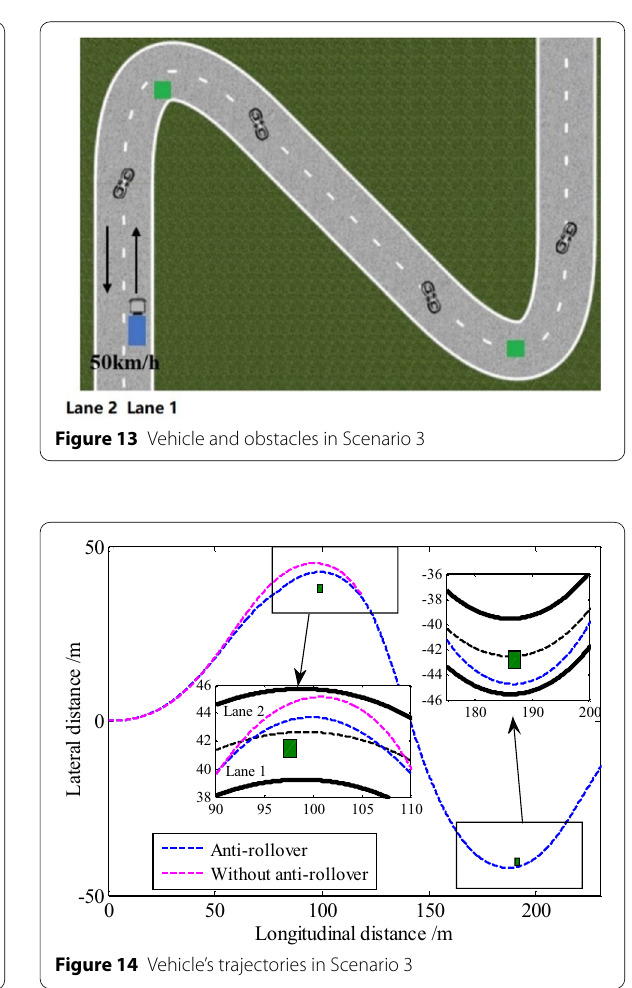
strategy still puts up a good performance in longitudi- nal stability in Scenario 2. Scenario 3: Extreme turning condition. As shown in Figure 13, an extreme urgent scenario is designed to vali- date the performance of the motion planning with active anti rollover ability. The intelligent heavy truck runs on a two-way lane at a speed of 50 km/h. There are two large detours in this section lane. A fixed obstacle of 1 m in length and width suddenly appears on Lane 1 when the ego vehicle is 15 m away from the first curve. Simi- larly, another fixed obstacle with length and width of 1 m appears on Lane 1, when the ego vehicle is 15 m away from the second curve. As shown in Figure 14, the blue curve and the pink curve represent the vehicle trajectories controlled by the motion planning strategy with and without active anti rollover ability in Scenario 3. Two green boxes are the fixed obstacles. Both the blue curve and the pink curve indicate that the vehicle can successfully avoid the first